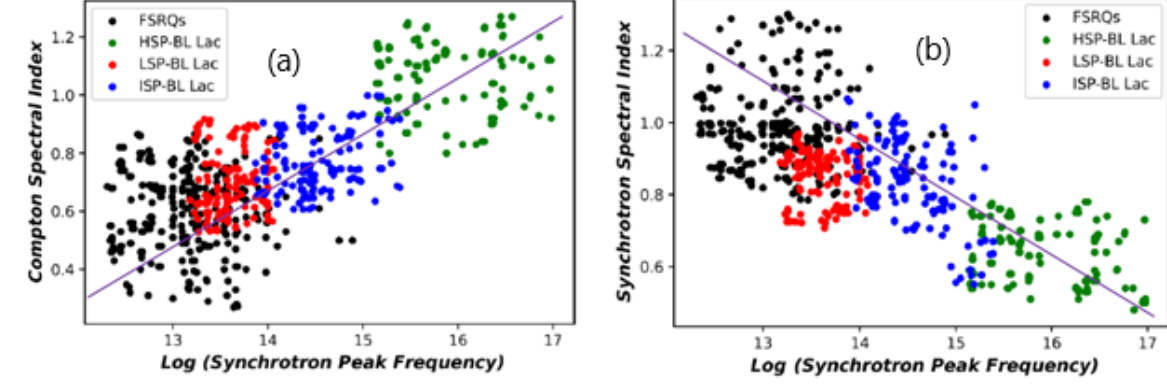
Figure 5. Scatter plot of (a) α com (b) α syn against ν peak for FSRQs and BL Lac subclasses